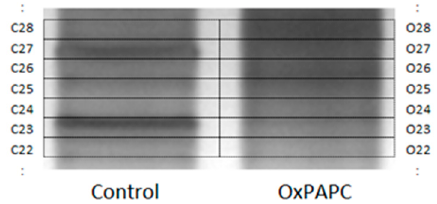
Figure 3. Representative region of a gel showing changes in pattern of protein silver staining. The grid shows how the bands were excised for in-gel trypsinisation and LC-MS/MS (liquid chromatography tandem mass spectrometry) analysis.